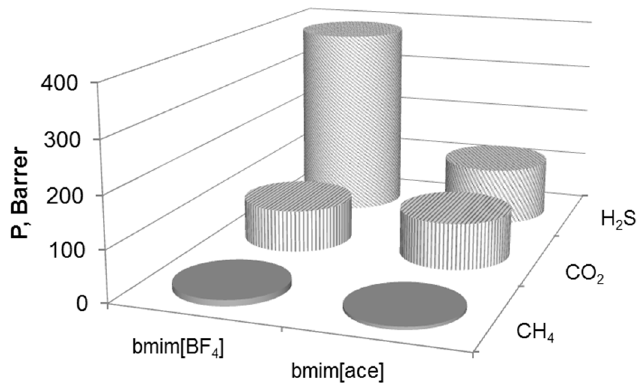
Figure 5. CH 4 , CO 2 and H 2 S gas permeability (Barrer) of SILMs based on bmim[BF 4 ] and bmim[OAc].